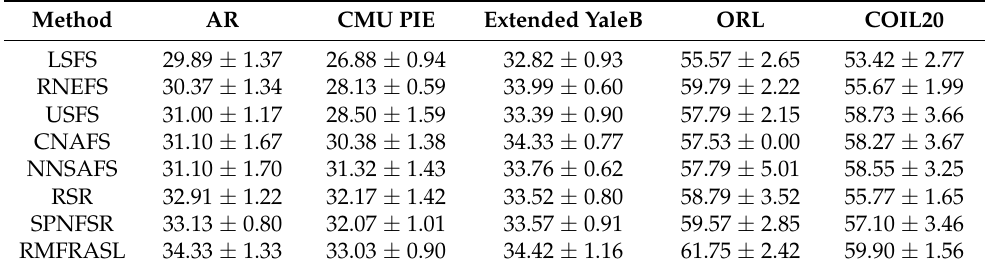
Table 9. The best ACC% and STD of different algorithms on the five databases.